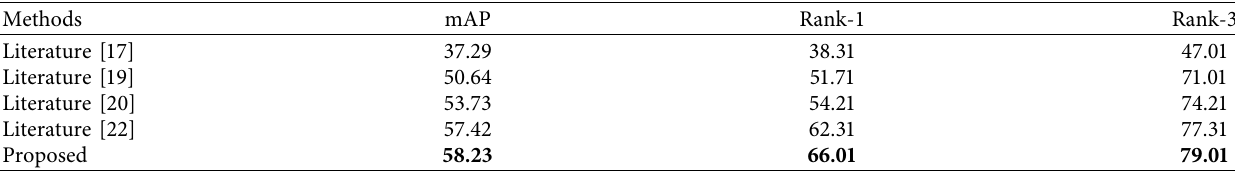
Table 1: The accuracy result on Market1501 datasets.